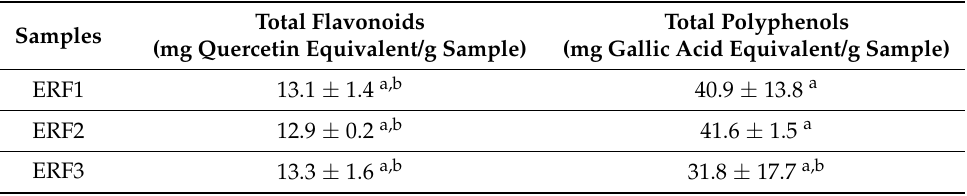
Table 1. Contents of total flavonoid and polyphenol levels in ER fractions